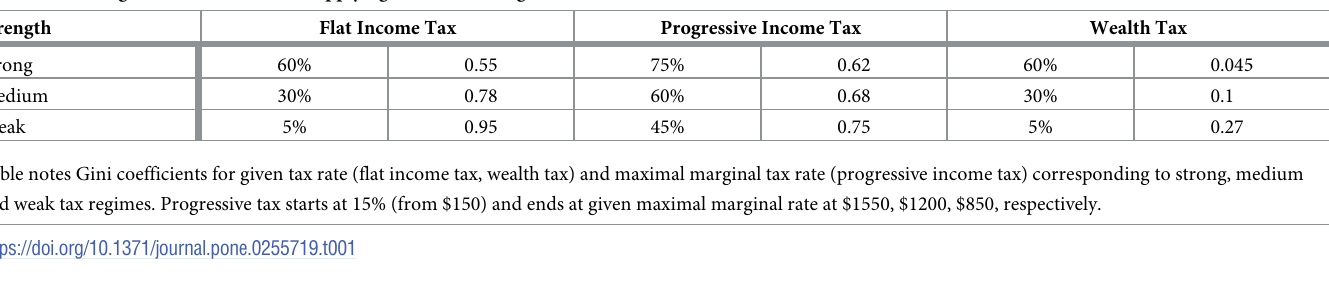
Table 1. Resulting Gini coefficients after applying different tax regimes for t = 100, 000 iterations. Strength